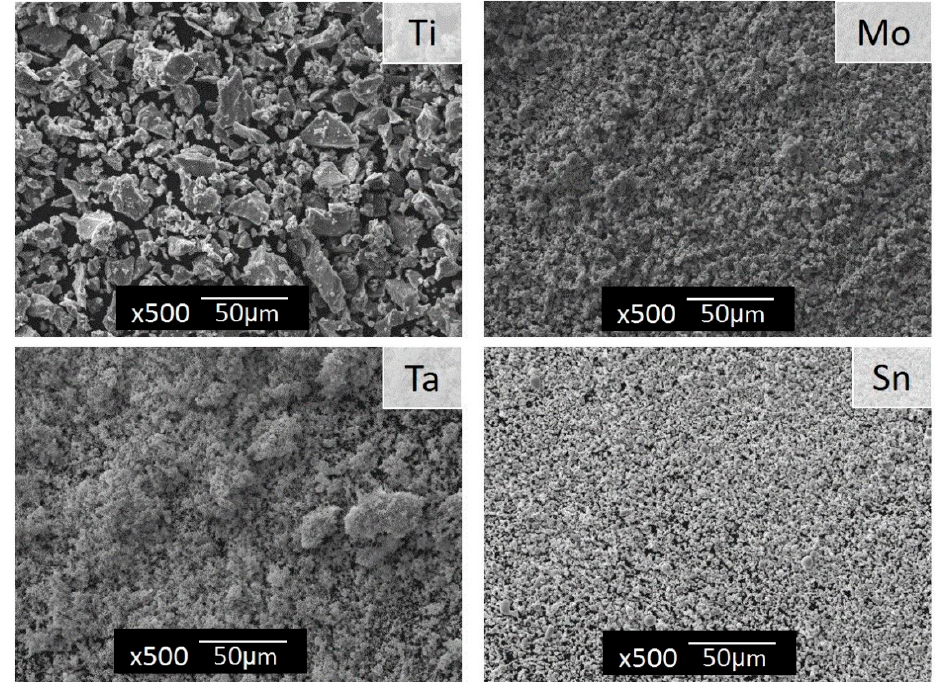
Figure 1. Scanning Electron Microscope (SEM) micrographs of the initial powders, Ti, Ta, Mo and Sn, showing different particle morphologies. The scale bar represents 50 μ m.